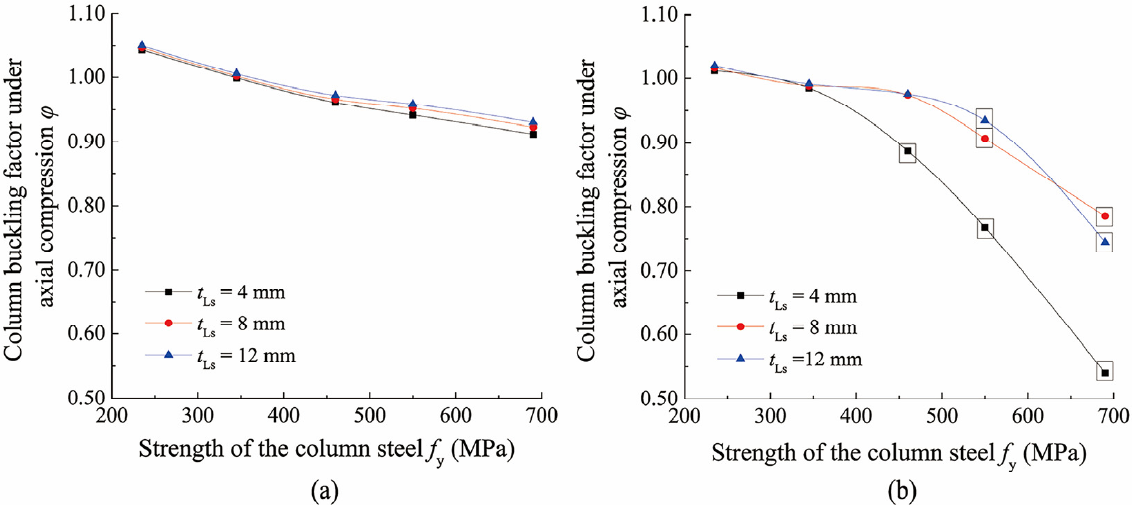
Figure 15. Relationship between column buckling factor and yield strength of column steel for varying stiffener thickness: ( a ) Model M1- t Ls , ( b ) Model M6- t Ls .